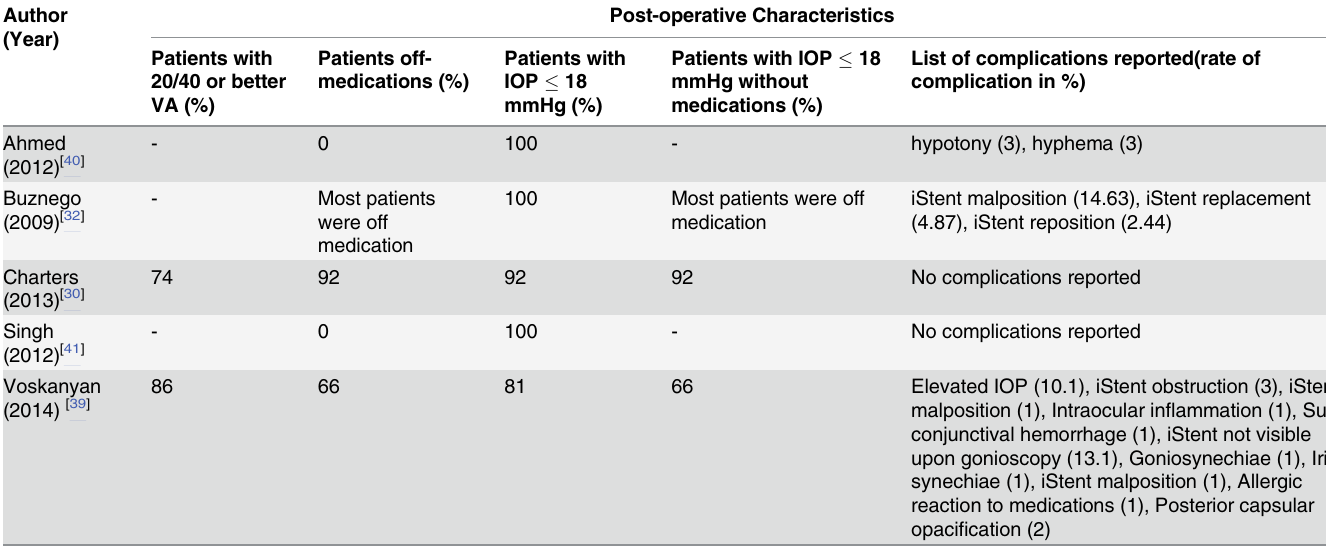
Two studies examined the insertion of two iStents. Two studies investigated the impact of one iStent on post-operative IOP and the number of medications. The follow-up periods for each study also varied significantly. One study reported six month follow-up period [40]. Two studies re- ported data up to 12-months [39,41] and one study reported an 18-months follow-up period [32]. Table 3 lists data on post-operative characteristics of included studies such as complications, complication rates, percentage of patients with good vision, reduced number of medications, and controlled IOP. Table 3. Reported post-operative characteristics and complications of studies included in meta-analysis. Author